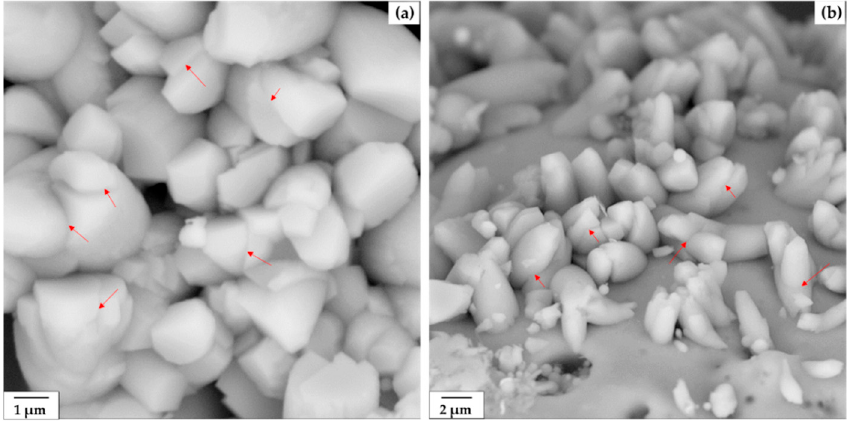
Figure 9. Growth morphologies of calcium carbonate crystals showing various precipitation direc- tions on the surface of cenospheres obtained from sink-float method, 1:10 fly ash-to-medium ratio, and 48 h soaking. The SEM images show ( a ) magnified area and ( b ) top view of the crystal precipitation. In the centrifugal method, the separation was performed under the applied speeds and times set at 10 and 30 min, particularly in the closed centrifuge tube with closed